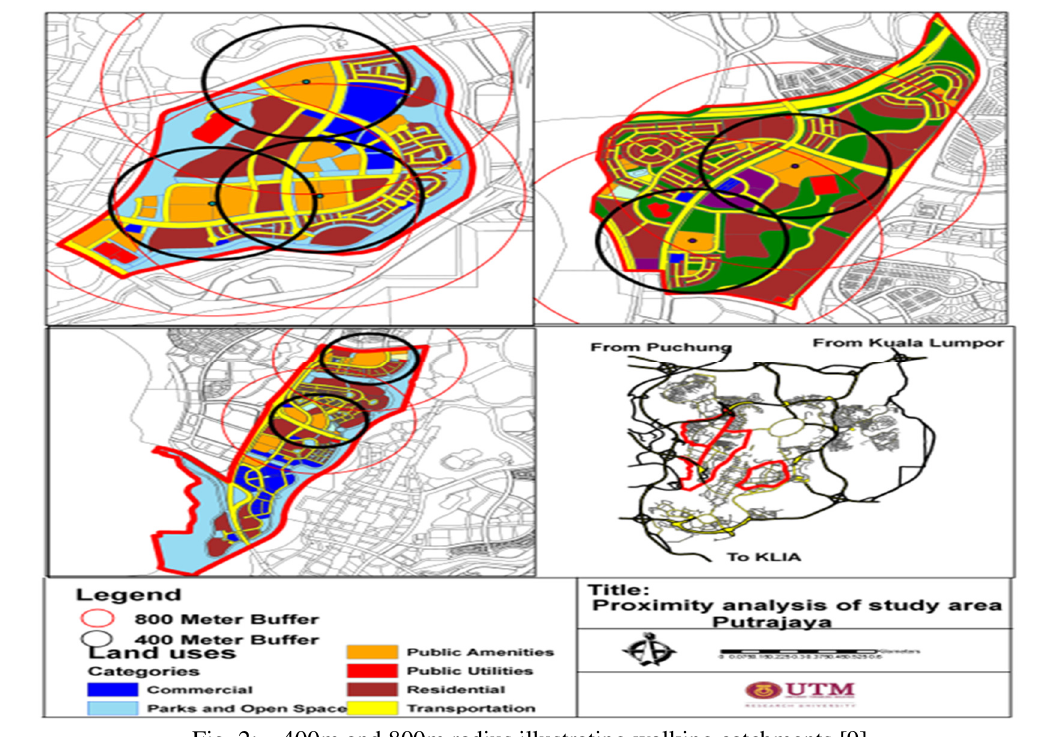
Fig. 2: 400m and 800m radius illustrating walking catchments